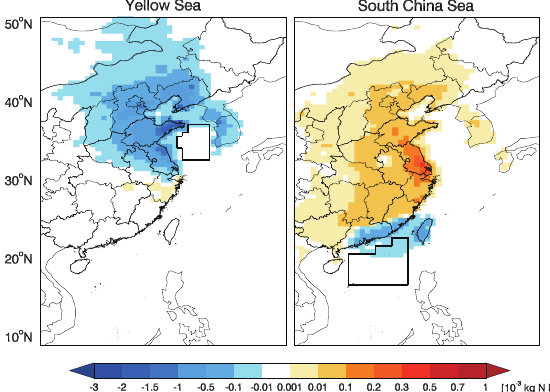
Figure 13. Sensitivity of NO y dry deposition over the Yellow Sea (left) and over the South China Sea (right) to NH 3 emissions in each model grid box for January